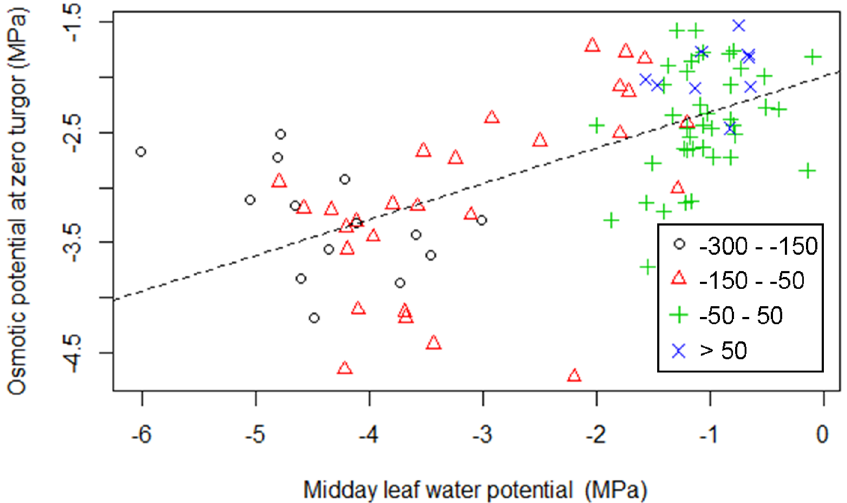
Figure 4. Relationship between the midday water potential and osmotic potential at full turgor ( n = 92). The data are grouped by four different levels of mean annual precipitation deficit (mm). The data are fitted with linear regression (red dashed line; r 2 = 0.43, p < 0.001).